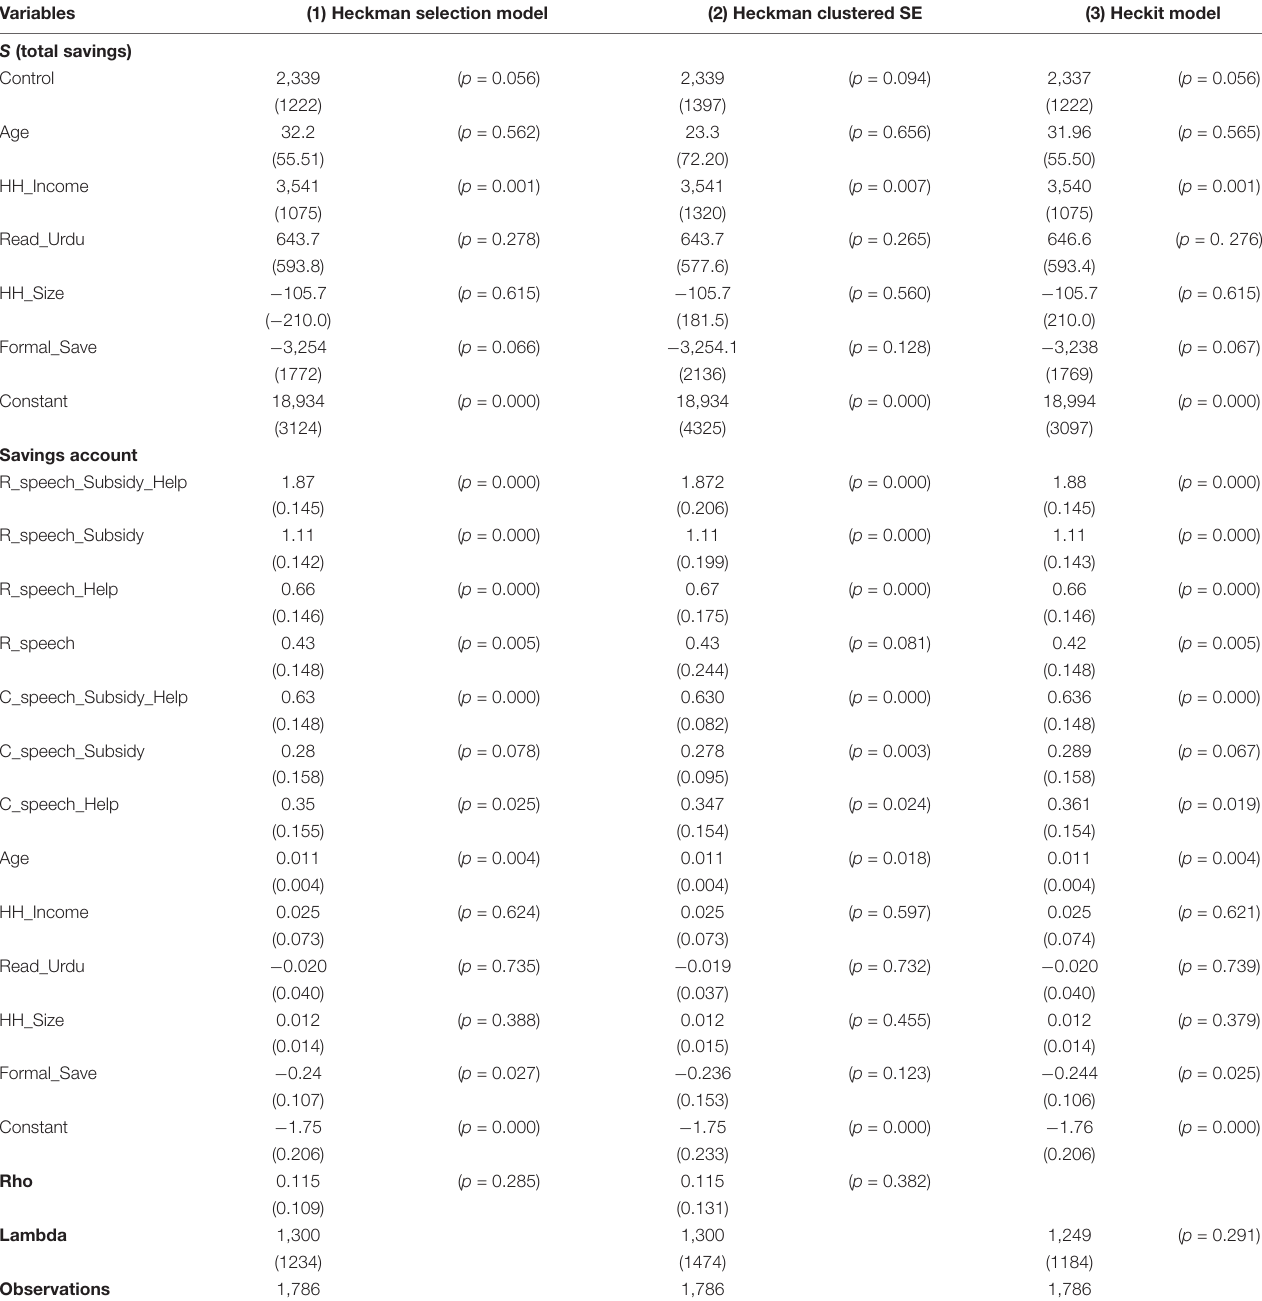
TABLE 3 | Heckman selection model